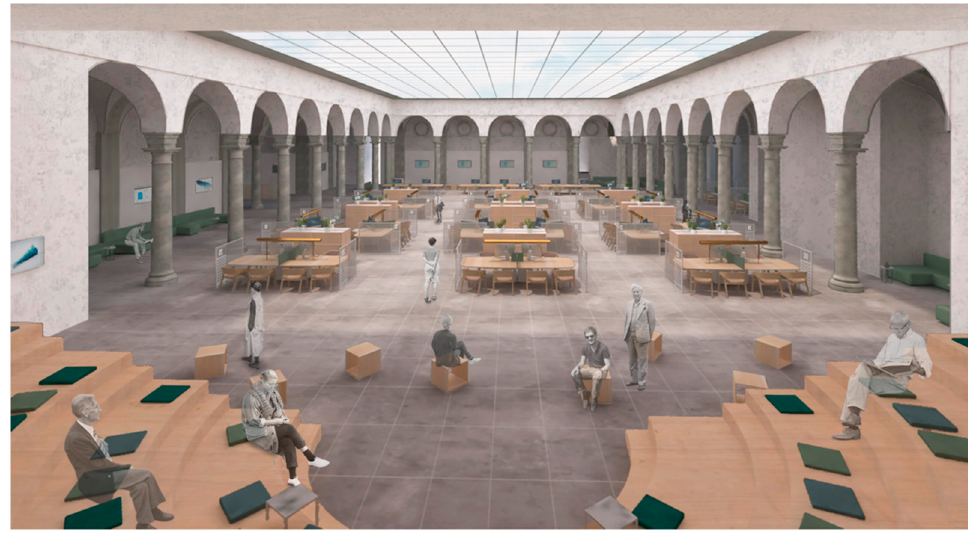
Figure 6. Rendering of the final Hall of the Future central atrium.